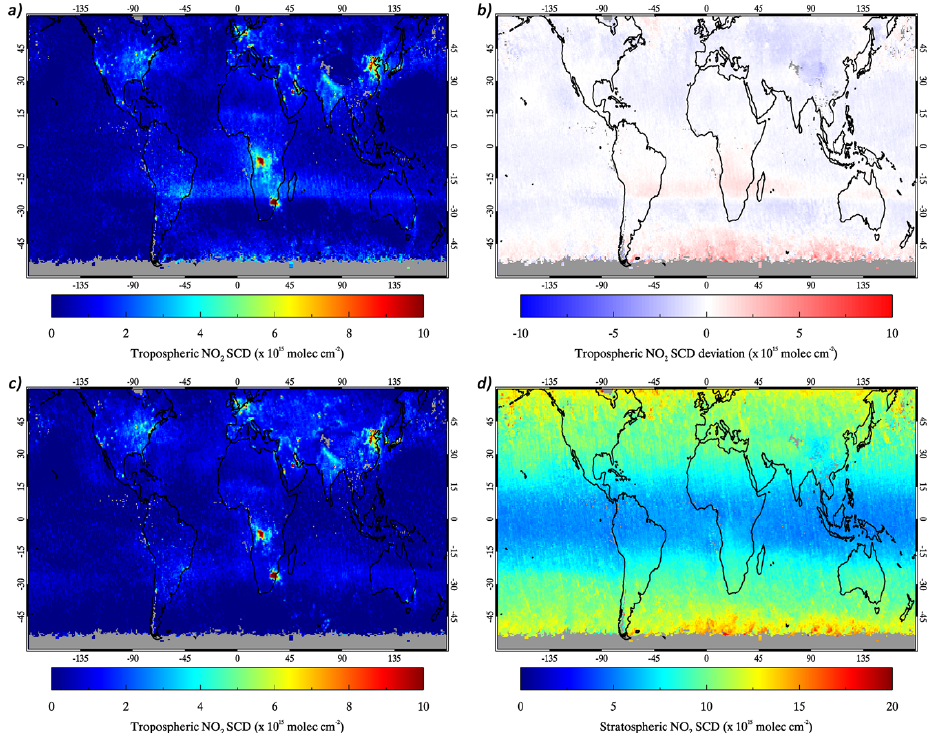
Figure 6. Comparison of average tropospheric NO 2 SCD retrieved during June 2005 using the ERrs-DOAS technique with DOMINO. (a) Average tropospheric NO 2 SCD retrieved using an Earth radiance reference. (b) Average bias between Earth radiance retrieval and DOMINO tropospheric SCD. (c) Average tropospheric NO 2 SCD retrieved by DOMINO. (d) Average stratospheric NO 2 SCD retrieved by